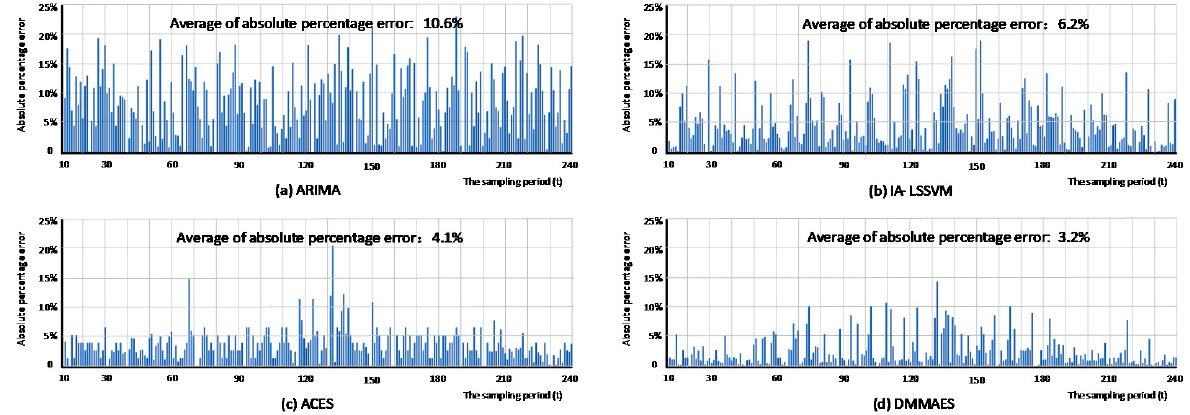
Figure 12. Histogram of the absolute percentage error of the average speed prediction results.